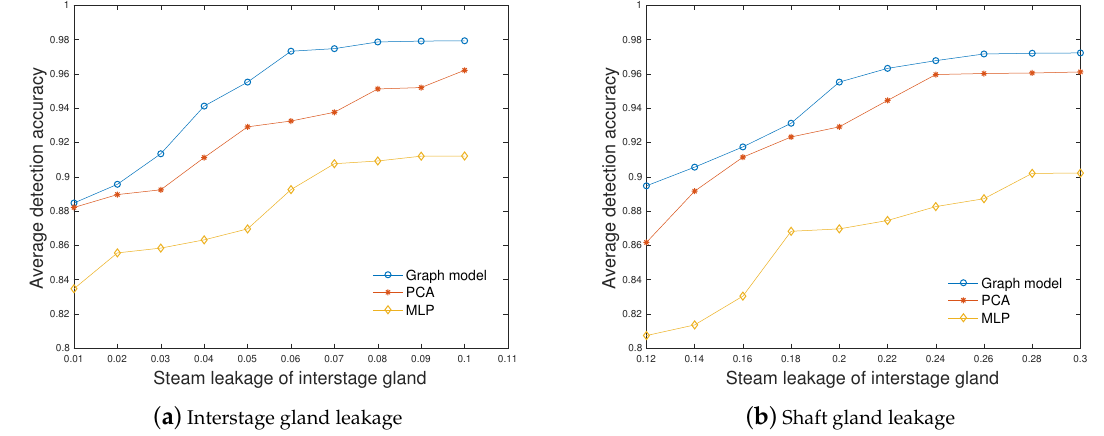
Figure 7. Average accuracy comparison of graph model, PCA and